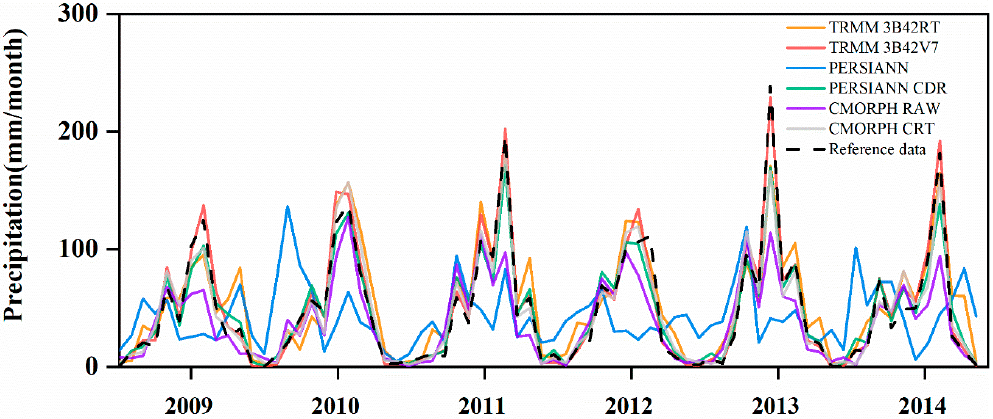
Figure 5. Temporal distribution of the monthly precipitation estimates over the whole basin.